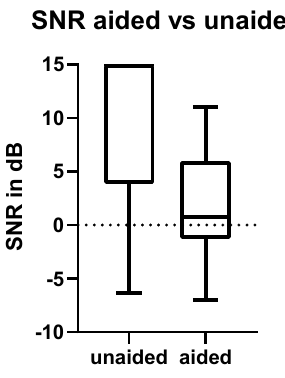
Figure 4. Oldenburger sentence test in noise. Signal-to-noise ratios in free-field with the device turned on (aided) and off (unaided) are shown. The difference is significant: p < 0.01.